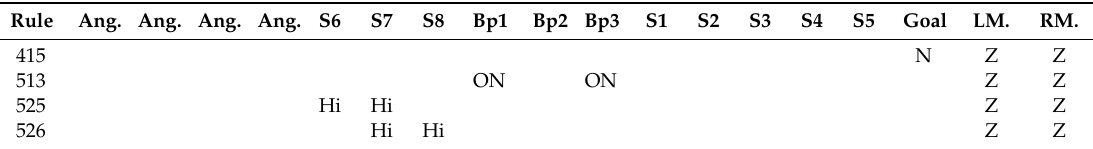
Table 3. Set of rules with Zero output for both